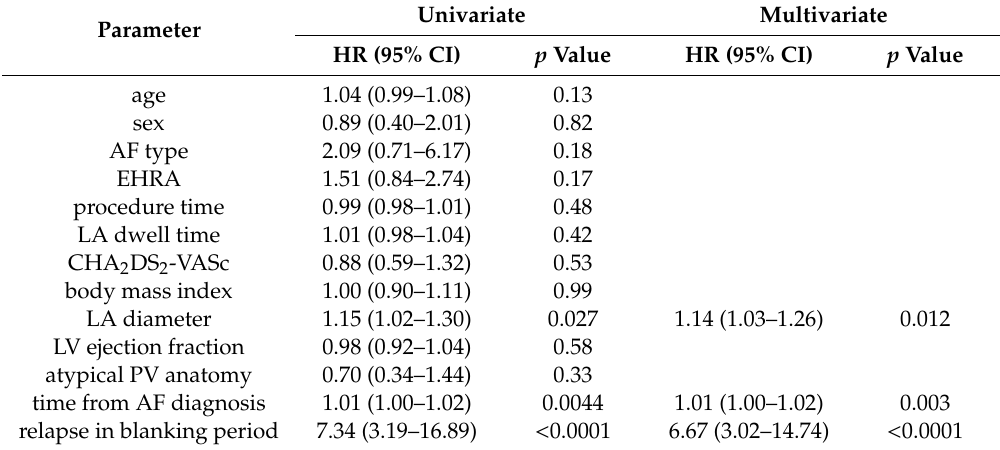
Figure 2. Arrhythmia-free survival in each tierce. Table 3. Uni- and multivariate Cox proportional hazard ratios for AF recurrence in 12-month